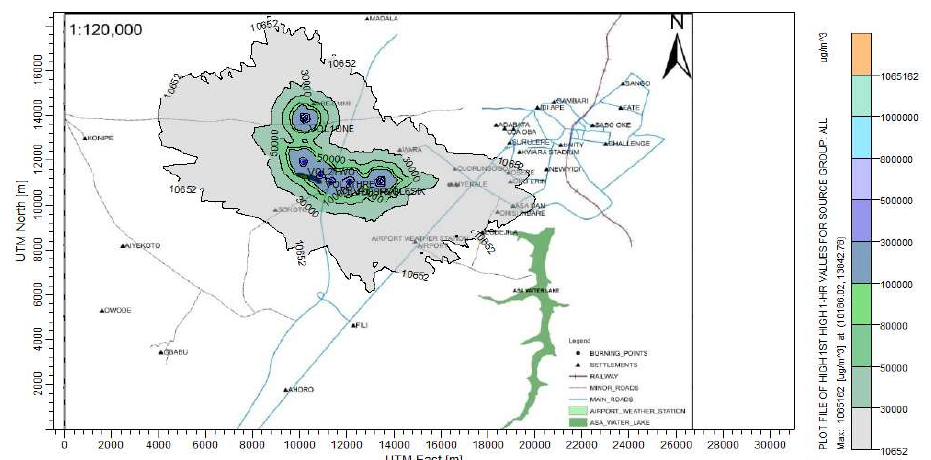
Figure 4. Isopleth of 1-h ground level CO from Sokoto-Aiyekale dump site.